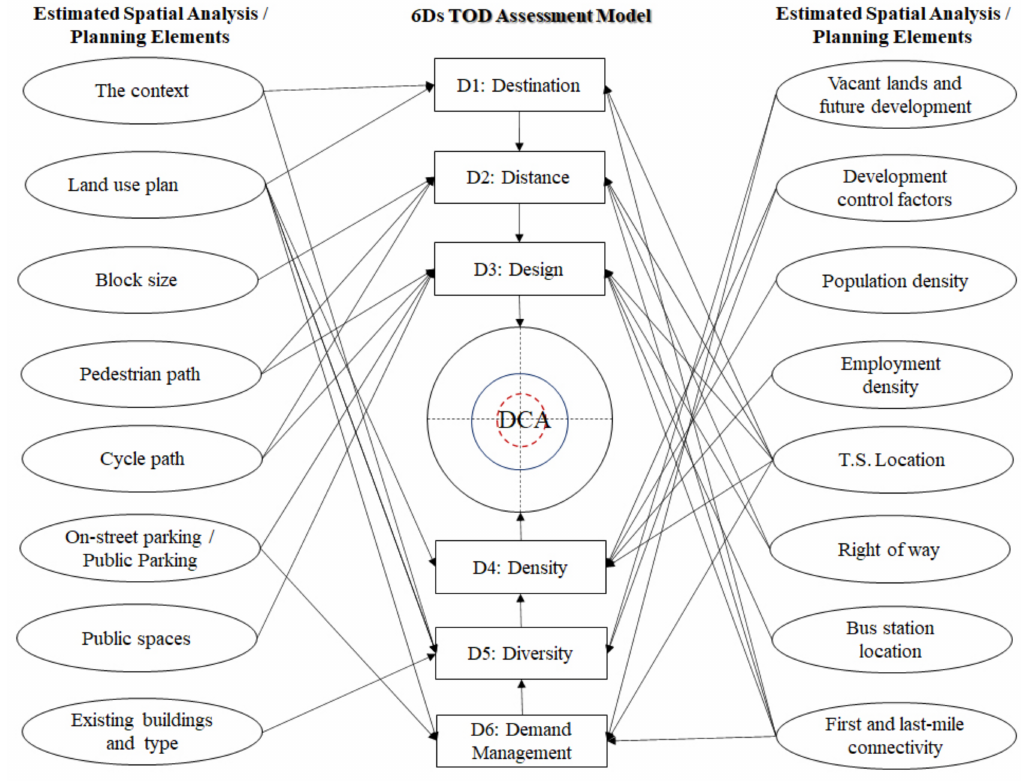
Figure 5. The relation between the investigated estimated spatial analysis through its planning elements with the elements of the 6Ds TOD assessment model when assessing the